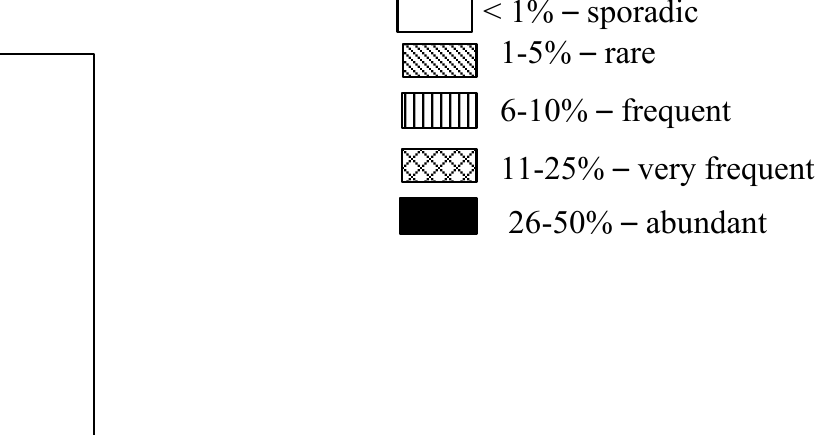
Water 2022 , 14 , x FOR PEER REVIEW